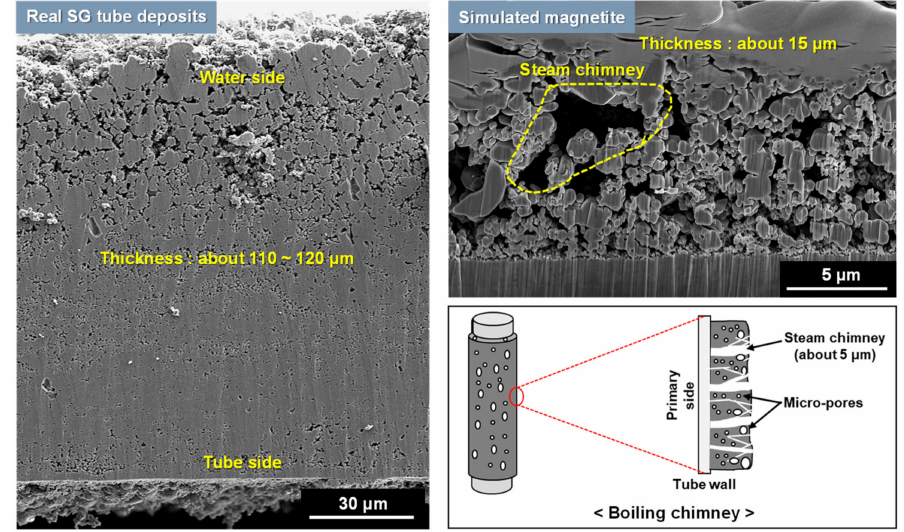
Figure 8. Cross-sectional view of the real SG tube deposits and simulated magnetite